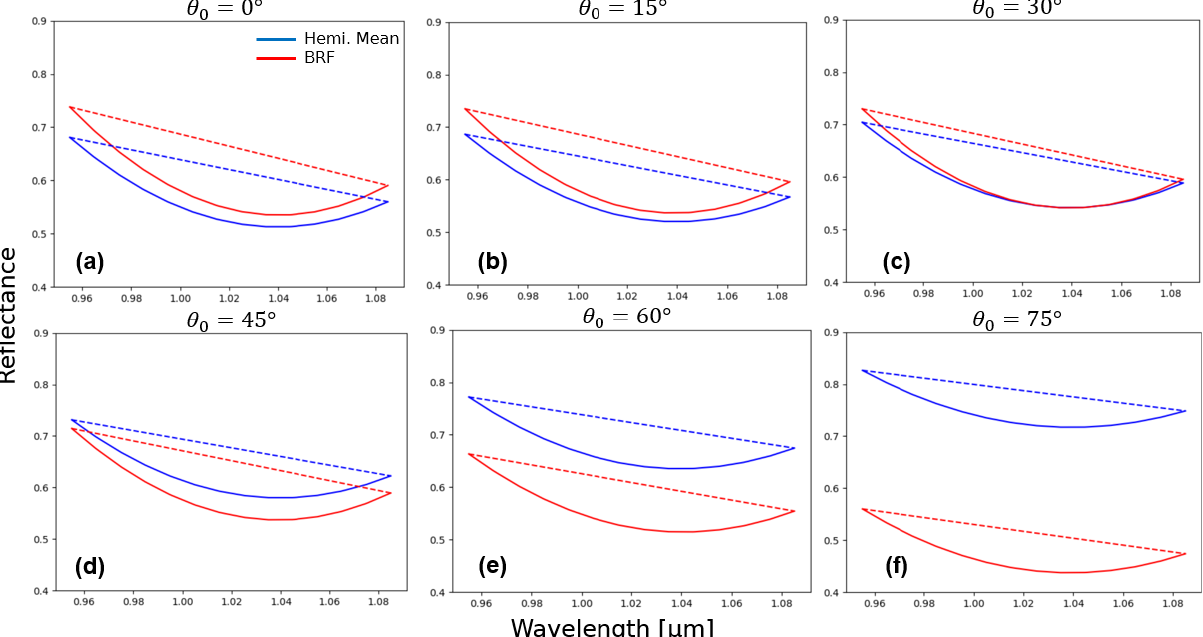
Figure 10. Spectral reflectance integrated across a hemisphere (“Hemi. Mean”, blue) and for the average BRF received at 0–15 ◦ (“BRF”, red) for r eff = 250µm at the prescribed illumination angles. The dashed lines represent continuum reflectance for the corresponding spectral